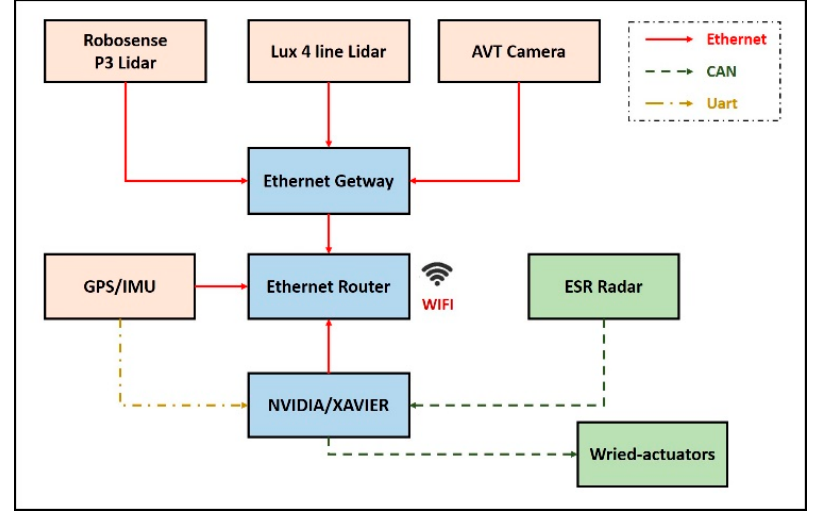
Figure 13. Hardware setup of Tianjin University’s autonomous vehicle.